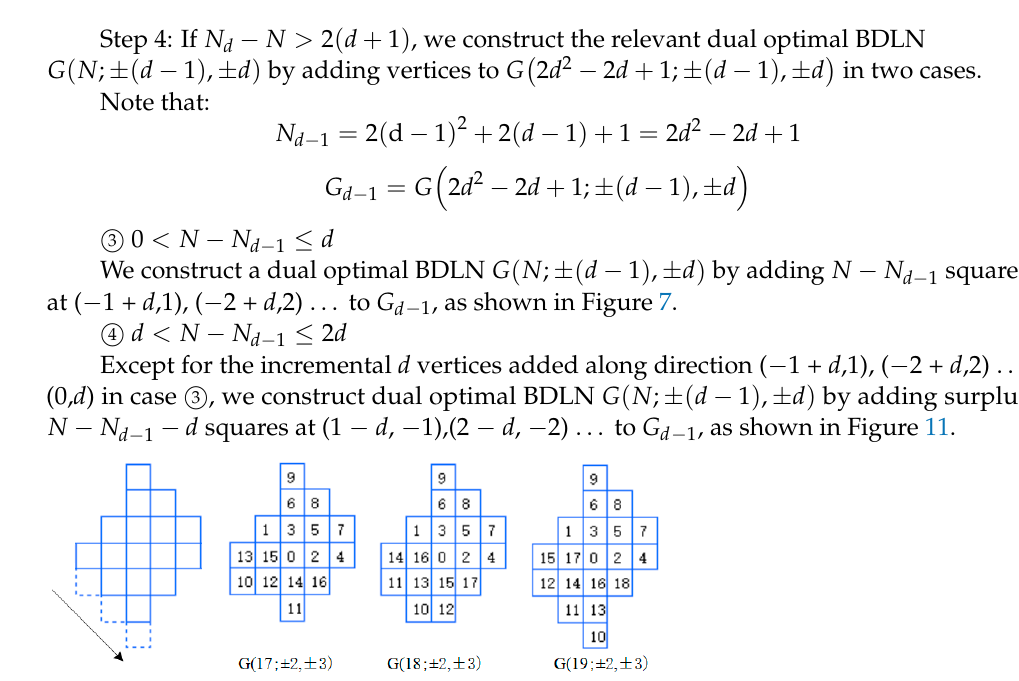
Figure 10. Deleting the other d + 1 layer vertices from G d .